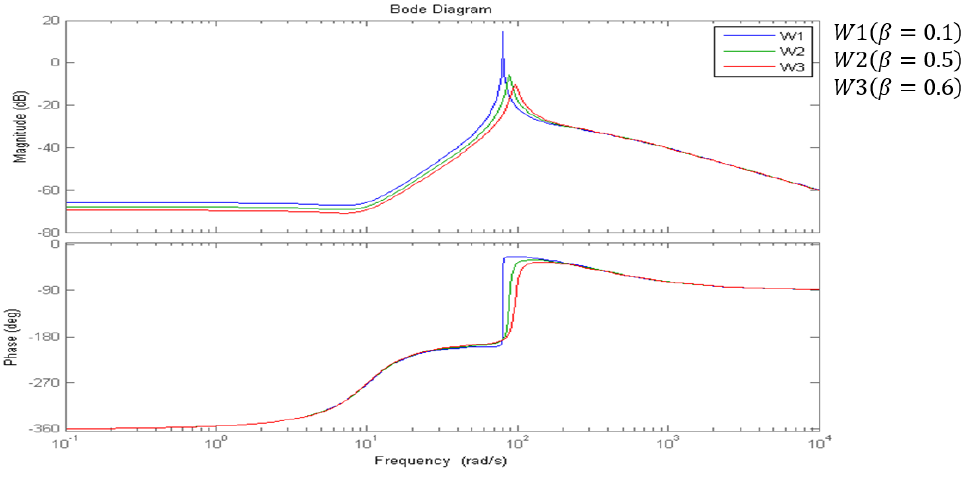
Figure 10. Frequency characteristics of the torque formation link for the traction motor.